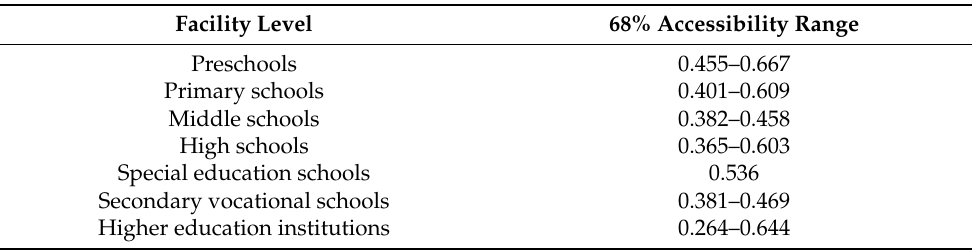
Table 14. 68% range of comprehensive urban land accessibility of the locations of various levels of educational facilities nationwide.